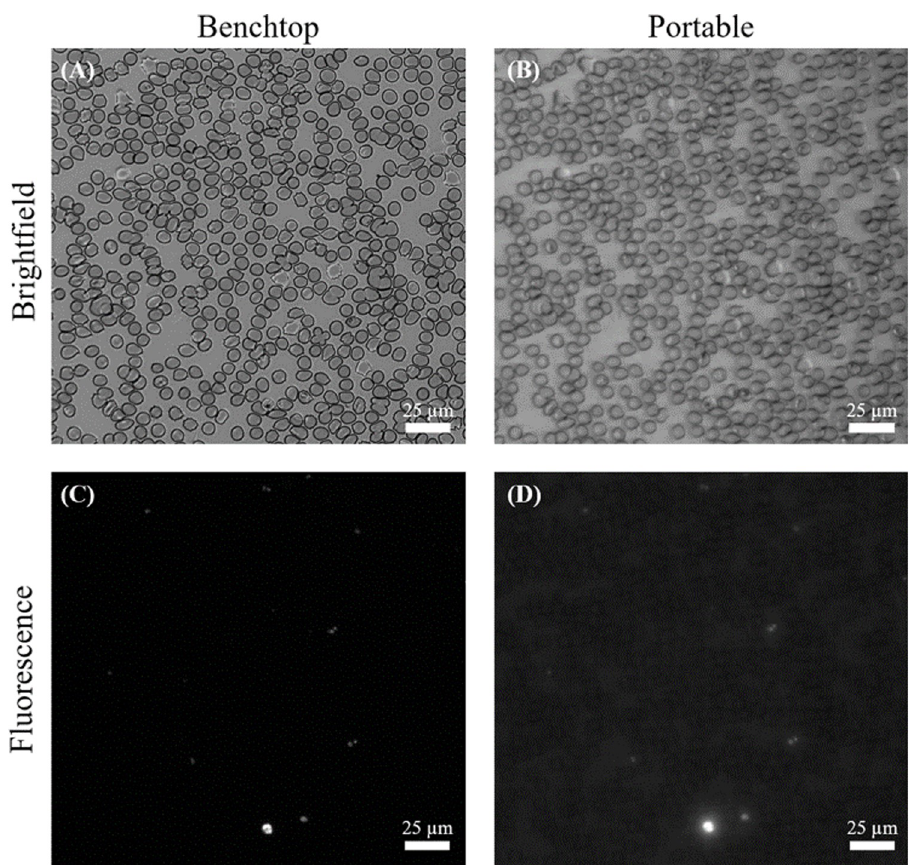
Fig 4. Brightfield (top) and fluorescence (bottom) images from the same FOV of Smear #3 for the benchtop control (left), and portable (right) microscopes. Images have been cropped and linearly contrast adjusted for clarity. Source benchtop images contain 4,275 cells and 44 parasites (1.0%) and source portable images contain 833 cells and 16 parasites (1.6%). The cropped images shown in the figure contain 593 cells.